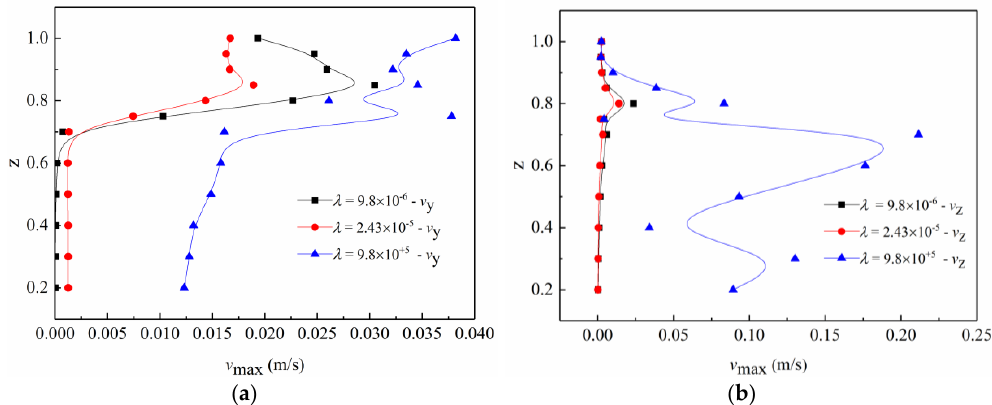
Figure 18. The vertical distribution of the maximum velocity at the tank center of sloshing under different baffle permeability coefficients. ( a ) Horizontal component of velocity; ( b ) Vertical component of velocity. (the unit of λ is m/s).